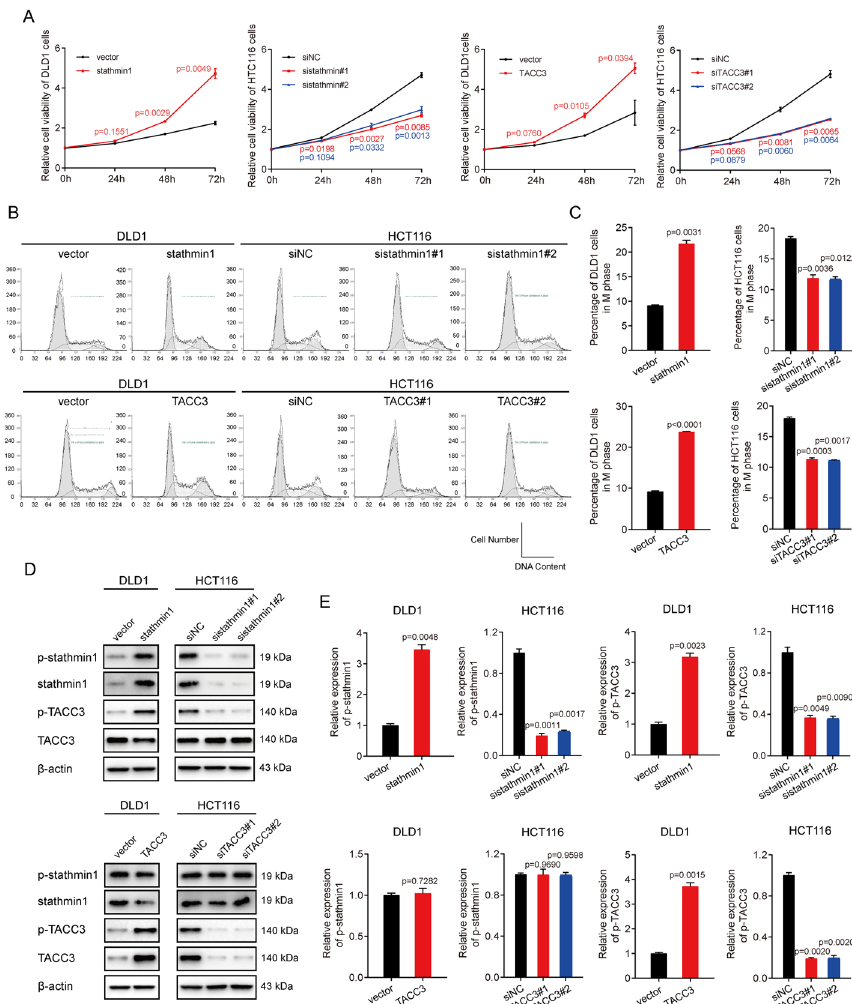
Fig. 4 Stathmin1 positively regulates the phosphorylation of TACC3 at Ser558. A DLD1 cells were transfected with pCMV-stathmin1, pCMV-TACC3, or pCMV-blank vector (final vector concentrations, 2 μg/ml), and HCT116 cells were transfected with stathmin1-specific, TACC3-specific, or non-specific siRNAs (final siRNA concentrations, 20 nM). Cell viability 0, 24, 48, and 72 h after transfection was measured using MTS assays. B DLD1 and HTC116 cells were transfected with vectors or siRNAs as shown in A . Cell cycle progression was analyzed by flow cytometry 48 h after transfection. C Percentage of cells in B that were in mitotic phase. D DLD1 and HTC116 cells were transfected with vectors or siRNAs as shown in A . Samples were harvested 48 h later, and the levels of indicated factors were determined by immunoblotting. E Relative levels of expression of the proteins shown in